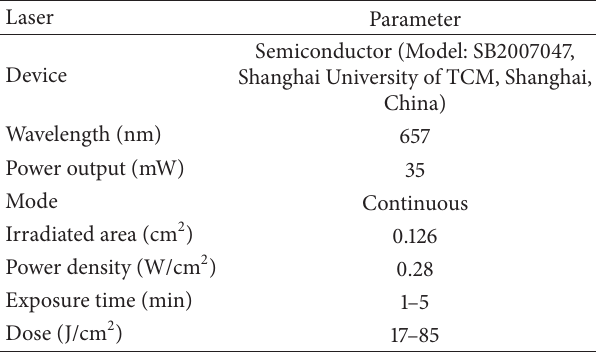
Table 1: Laser system and parameters.